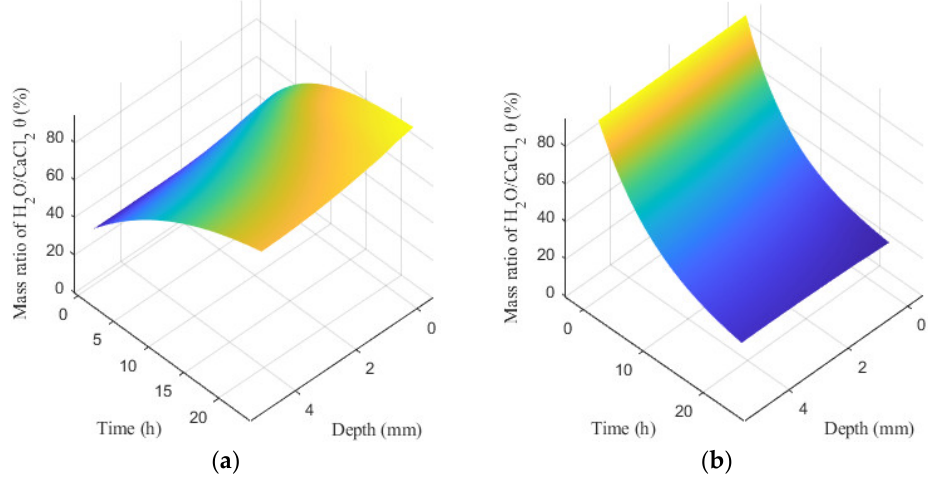
Figure 15. Mathematical model: ( a ) Absorption at 25 °C and ( b ) desorption at 50 °C.